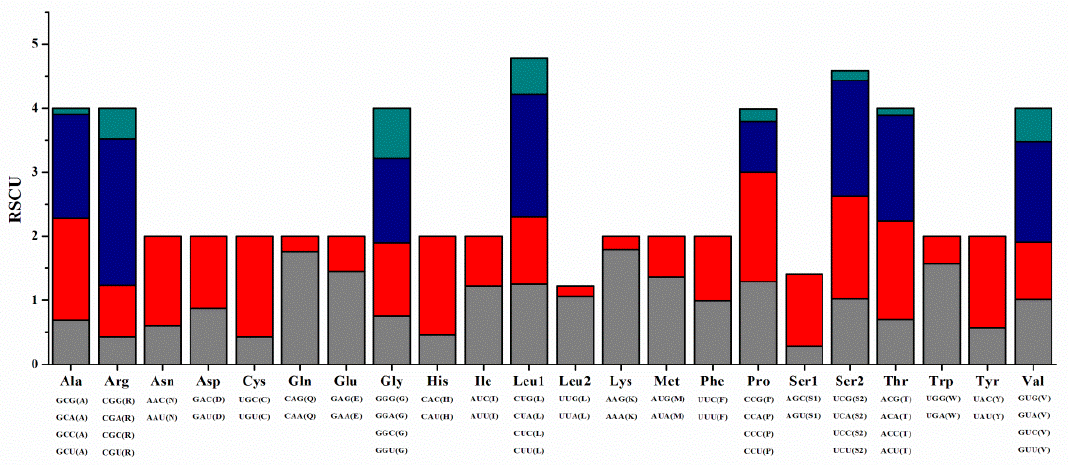
Figure 1. Relative synonymous codon usage (RSCU) of the C . crocodilus mitogenome.